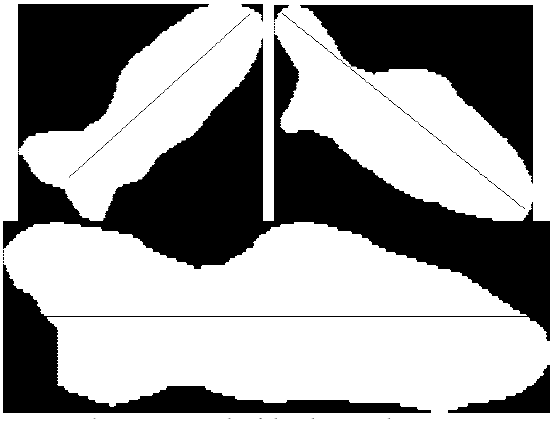
Figure 18 . Length of the object in the image. Figure 18. Length of the object in the image.